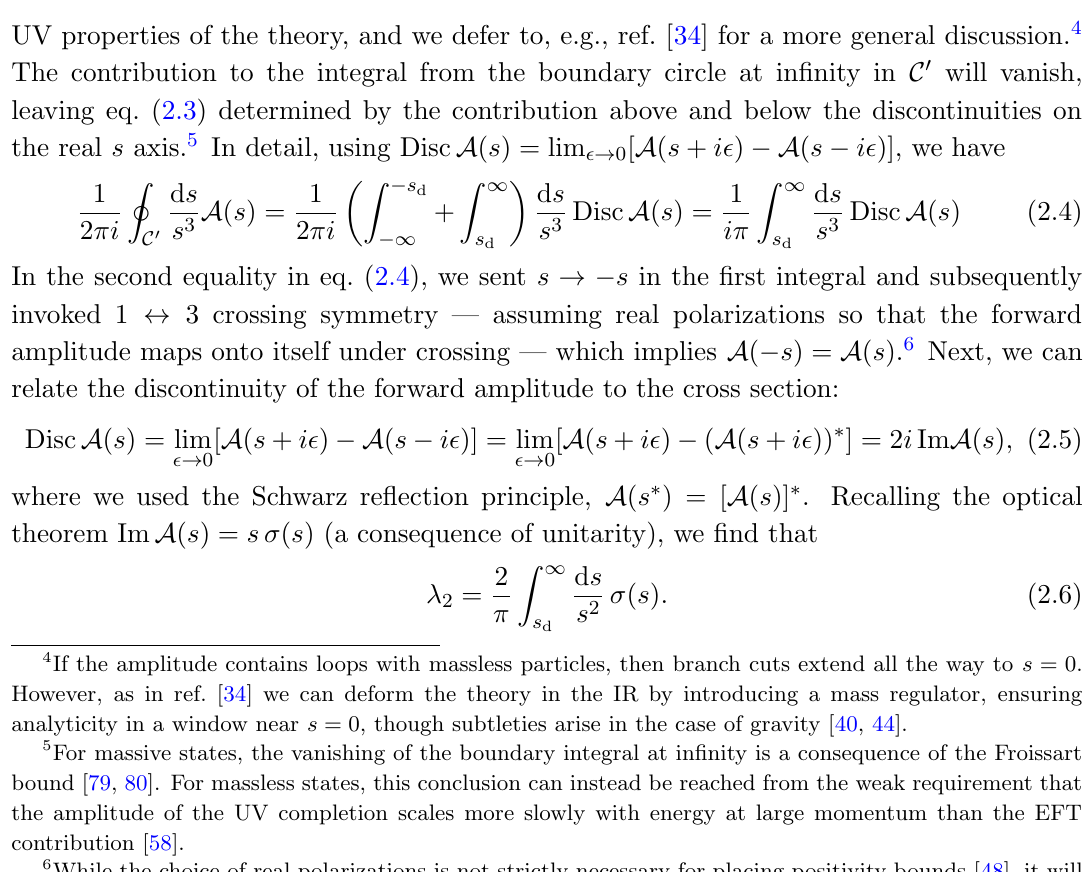
Figure 2 . A schematic depiction of the analytic structure of the amplitude in the complex s plane, as well as the two contours we will use to establish our positivity bounds. The zigzag lines denote the discontinuity in the amplitude, which can include poles and branch